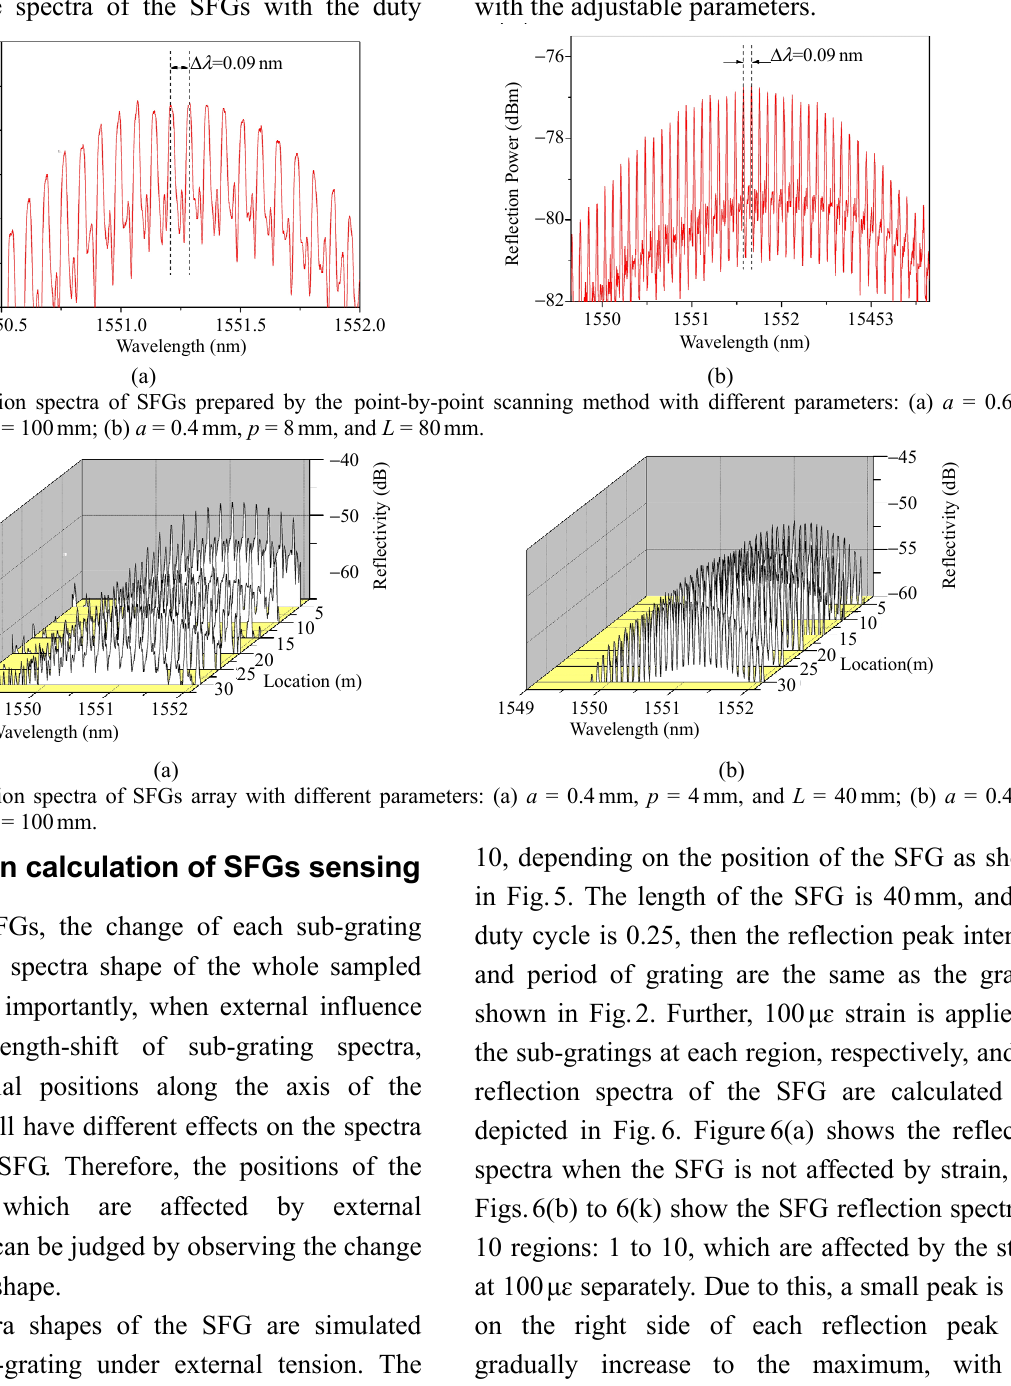
10 regions: 1 to 10, which are affected by the strain at 100 μɛ separately. Due to this, a small peak is split on the right side of each reflection peak and gradually increase to the maximum, with the affected region changing from Region 1 to Region